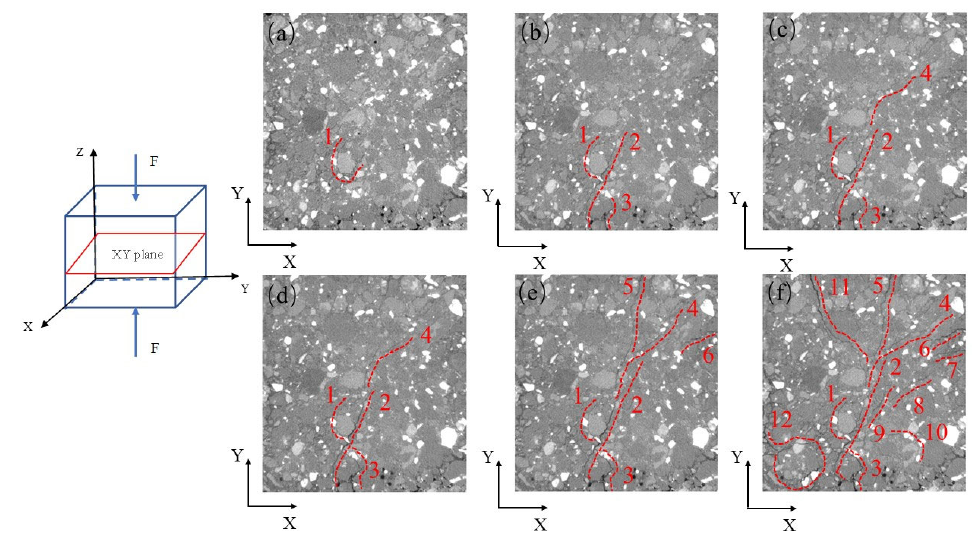
Figure 6. Two-dimensional crack distributions in the central section (XY plane) of cement mortar at different loading stages. ( a ) F = 0 N; ( b ) F = 2000 N; ( c ) F = 2500 N; ( d ) F=3000N; ( e ) F = 3600 N; ( f ) F = 5000 N.